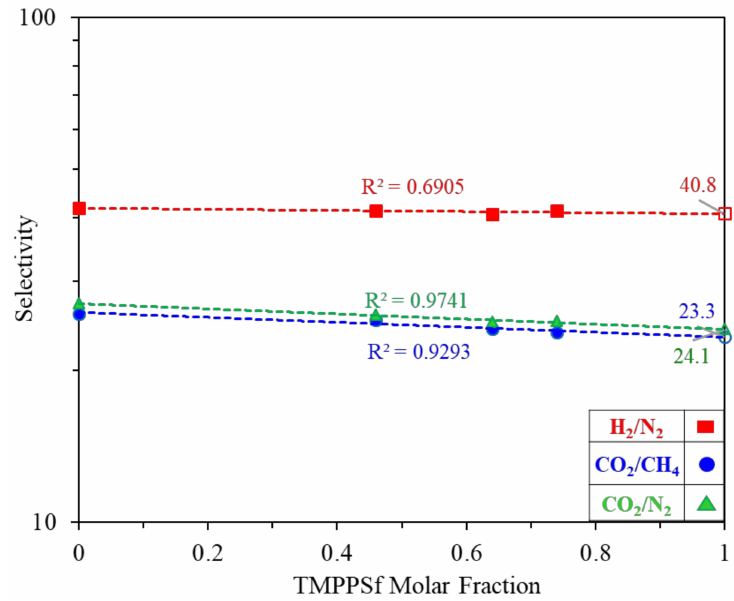
Figure 9. Relationship between selectivity coefficient and TMPPSf